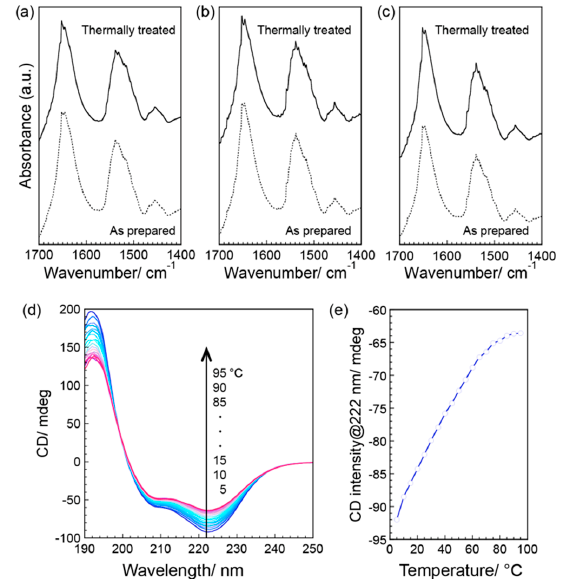
Figure 4. Secondary structural analyses of M13 phages. ( a – c ) Attenuated total reflection/infrared (ATR/IR) spectra of the ( a ) outside, ( b ) midpoint, and ( c ) center of the films. Solid and dotted lines represent the thermally treated and as prepared films, respectively. ( d , e ) Circular dichroism (CD) spectra of M13 phages in an aqueous solution. ( d ) CD spectra of M13 phages at different temperature (5–95 °C, every 5 °C). ( e ) CD intensity at 222 nm as a function of temperature. Phage concentration is 5 nM.